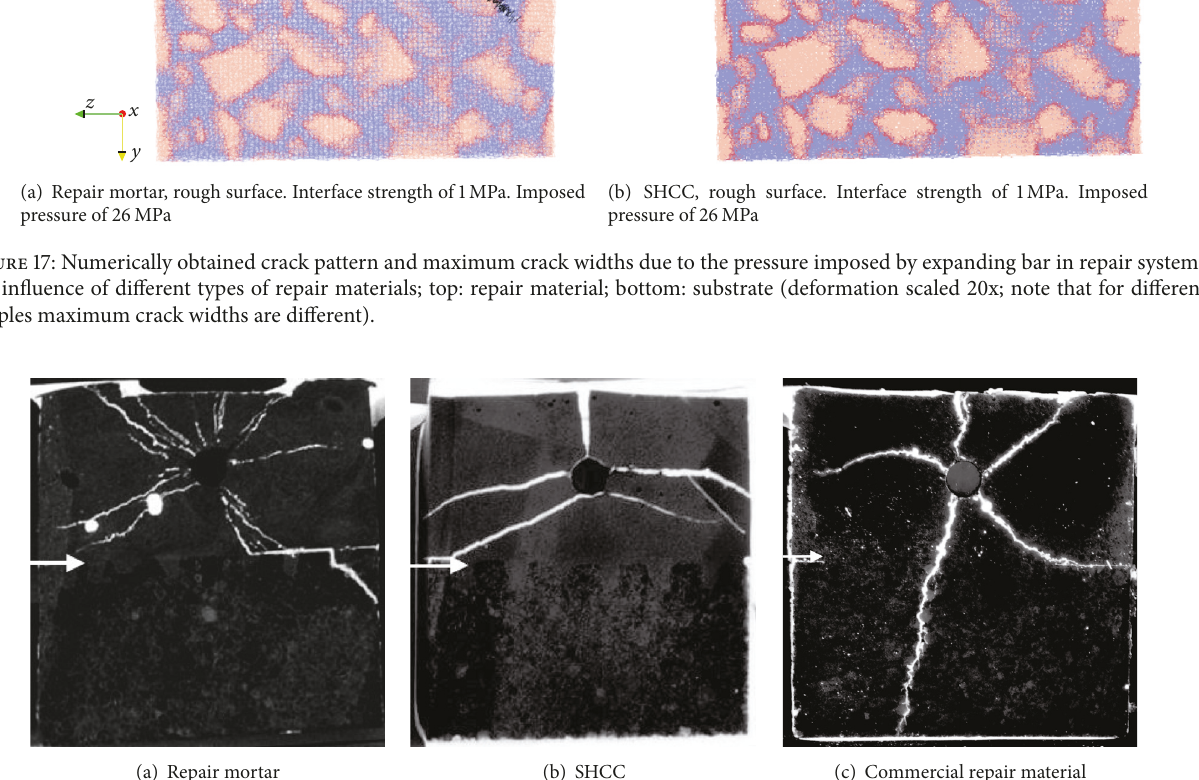
Figure 18: Experimentally obtained damage patterns (top: repair material; bottom: mortar substrate; interface is indicated with the arrow); samples are epoxy impregnated and imaged under UV